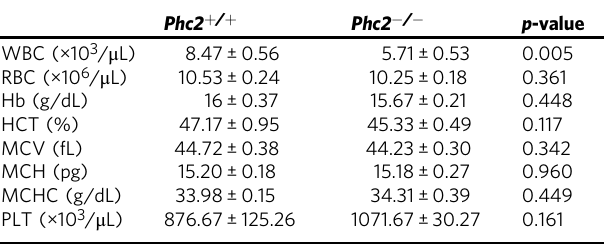
Table 2 Complete blood counts in Phc2 + / + and Phc2 − / − mice